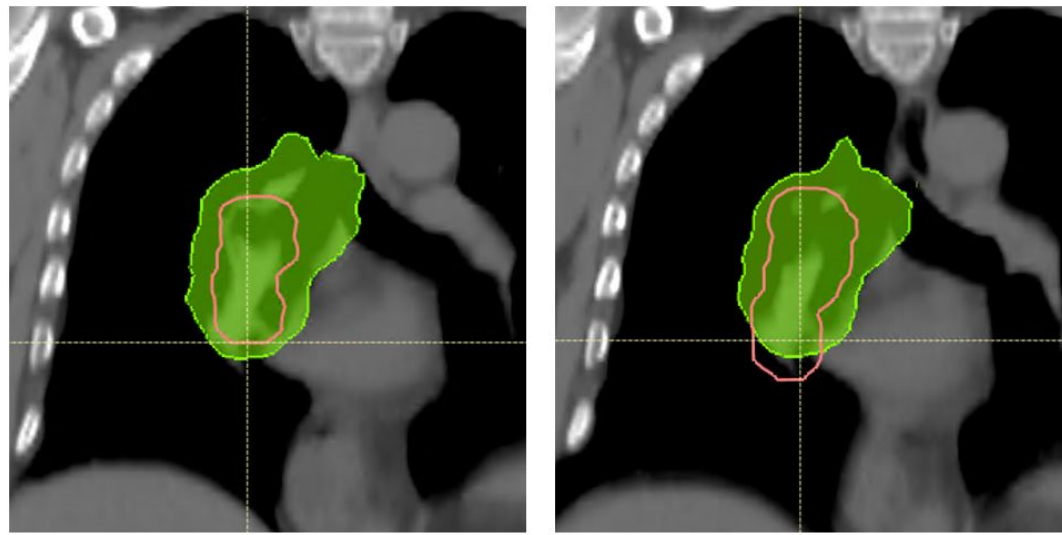
Figure A2. SFUD plan for patient 3. Deeper breathing and increased breathing motion causes the CTV (pink) in the mediastinum to extend 15 mm more caudally and 3 mm more cranially on the Start AIP ( right ) compared to the Plan AIP ( left ). The yellow cross shows a reference position in both images. The 95% isodose (green) does not cover the caudal area of the CTV at Start. Notably, the diaphragm position had also changed in this patient, and this change would be detectable on CBCT imaging.